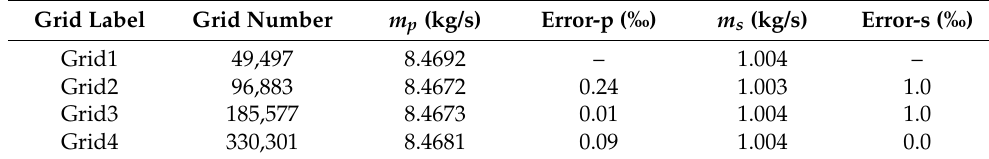
Table 4. Grid independence analysis